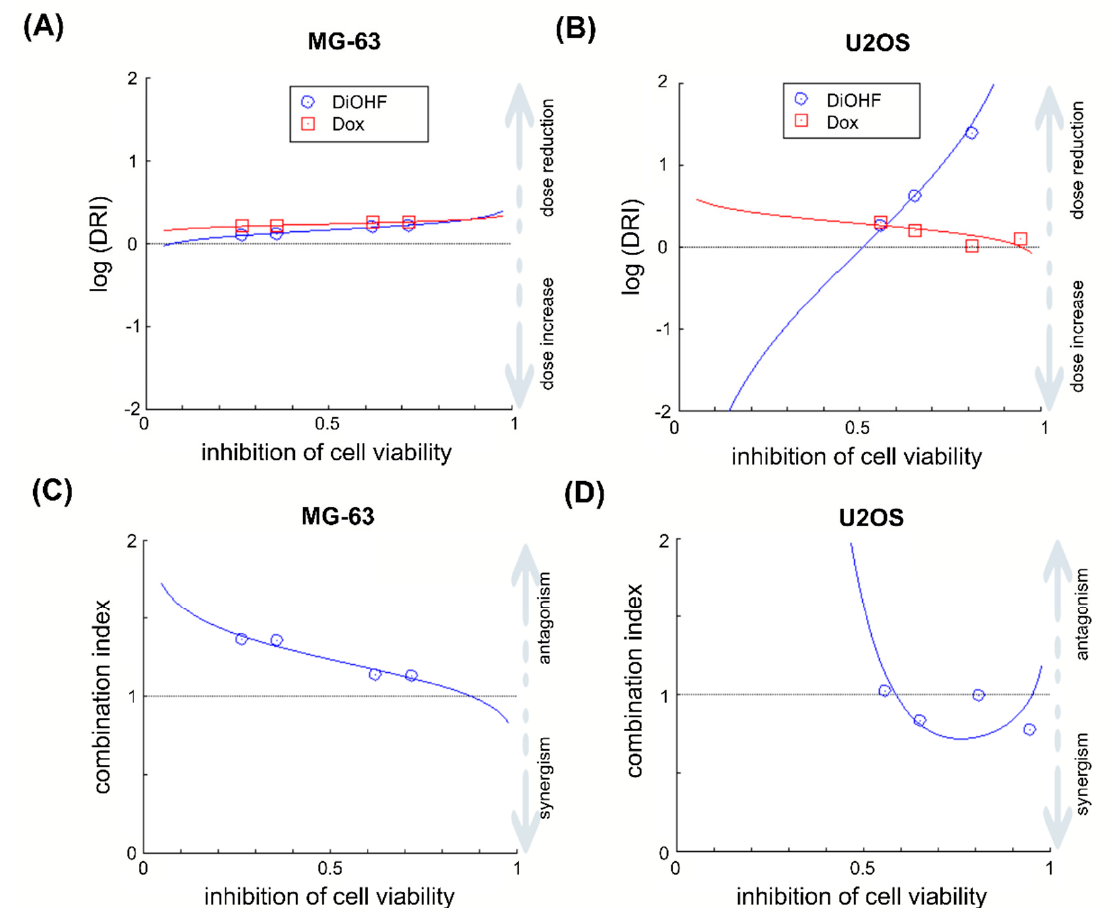
Figure 2. Combination effects of DiOHF and Dox ( A , C ) MG ‐ 63 and ( B , D ) U2OS cells were incubated for 48 h with DiOHF (39.5, 59.3, 133 and 200 μ mol/L), Dox (0.222, 0.333, 0.75 and 1.125 μ mol/L) or their respective increasing combinations. After MTT assay, a combination analysis was performed to identify for each combination ( A , B ) the dose reduction of each drug and ( C , D ) drug synergism.